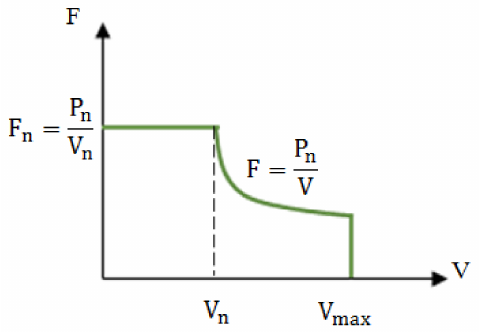
Figure 2. Traction performance curve.